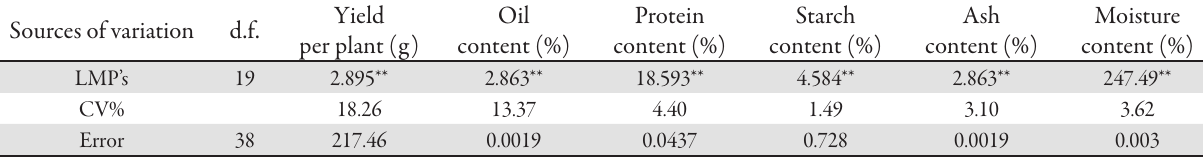
128 Tab. 2. Mean squares for grain yield and quality parameters of 20 Kosovo local maize populations Sources of variation